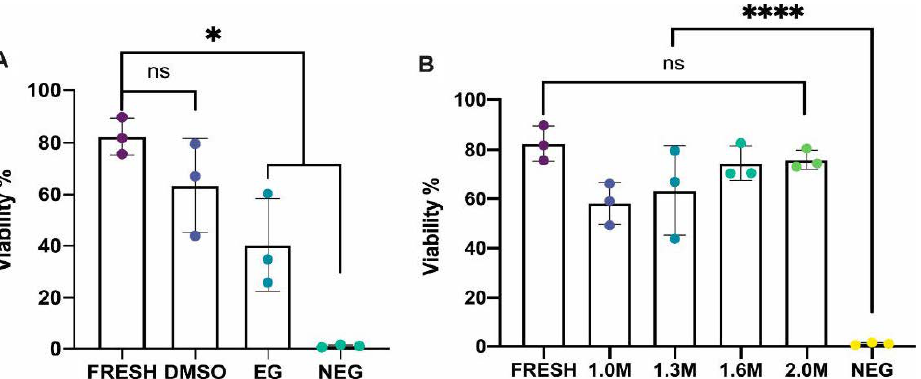
Figure 4. Comparison of ovarian cells viability between various concentrations of cryoprotectants and against fresh and negative controls. ( A ) In experiment 1, whole ovaries from twelve ( n = 12) fish were allocated to one of four treatment groups. Ovaries cryopreserved using 1.3M dimethyl sulfoxide (DMSO) resulted in a higher cell viability in comparison to 1.3 M ethylene glycol (EG) and this was not significantly different to fresh control samples. The viability of the EG treated samples and the negative control samples were both significantly different compared to the fresh control ( p = 0.018 and p = 0.0003 for Fresh vs EG, and Fresh vs Neg samples, respectively; minimum level of significance indicated by *). ( B ) In experiment 2, DMSO also was tested at concentrations of 1.0 M, 1.6 M and 2.0 M with nine ovaries ( n = 9) allocated to one of the three treatments. No significant difference was found in cell viability between the different concentrations of DMSO and fresh controls (non-significance indicated by “ns”), but all samples were significantly different to the negative control ( p < 0.0001, level of significance indicated by ****; One-way ANOVA with Tukeys post hoc test, data shown as mean ± standard deviation).